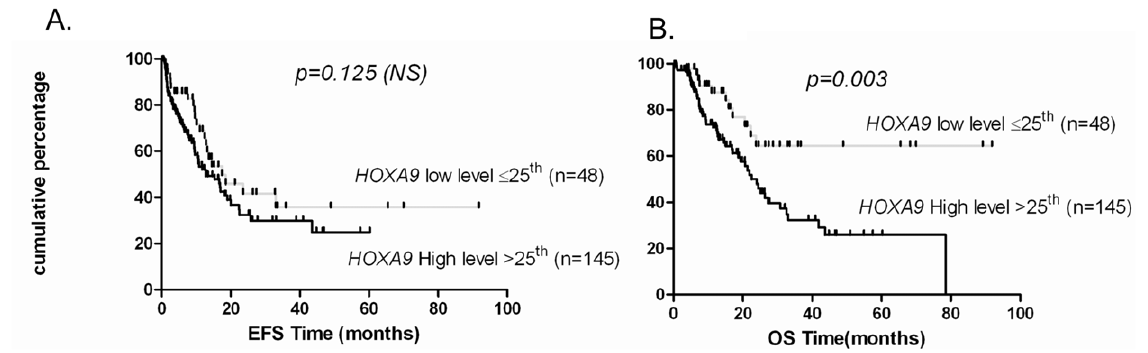
Figure 4. Low HOXA9 expression associates with better survival outcome. Kaplan Meier analysis of two groups with expression levels above or below the cut-off at the first quartile for HOXA9 expression. (A) Event free survival (EFS) and (B) Overall survival (OS) were assessed in 193 patients.